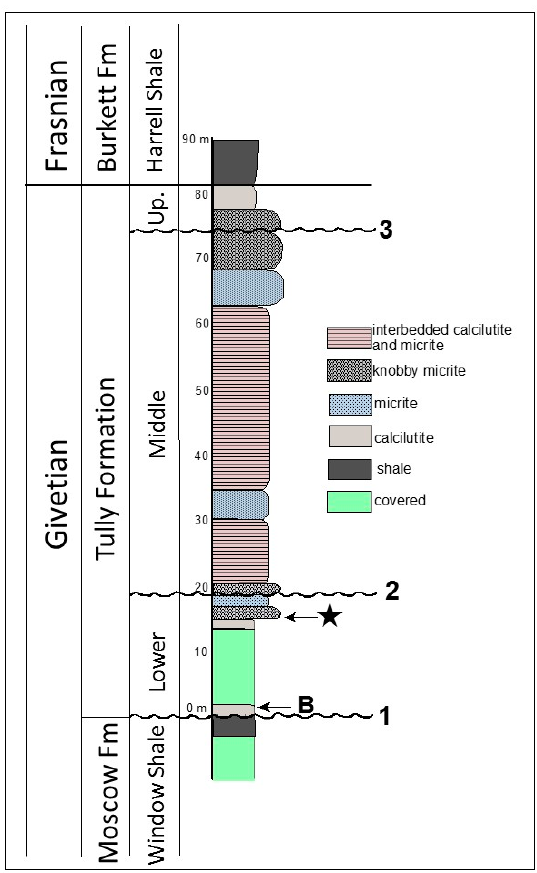
Figure 2. Stratigraphic column for the Lock Haven exposure of the Tully Formation. Star indicates the position of the microfossils described here. B indicates the position from which the index brachiopods Camarotoechia mesocostale, Rhyssochonetes aurora, and Emanuella subumbona were recovered. Disconformities: 1—disconformity at Tully/Moscow contact; 2—inferred position of disconformity representing the maximum flooding surface of Baird and Brett [38,39] separating the Lower and Middle Tully Formation; 3—Heckel’s [36,37] disconformity defining the base of the Upper Tully Formation.